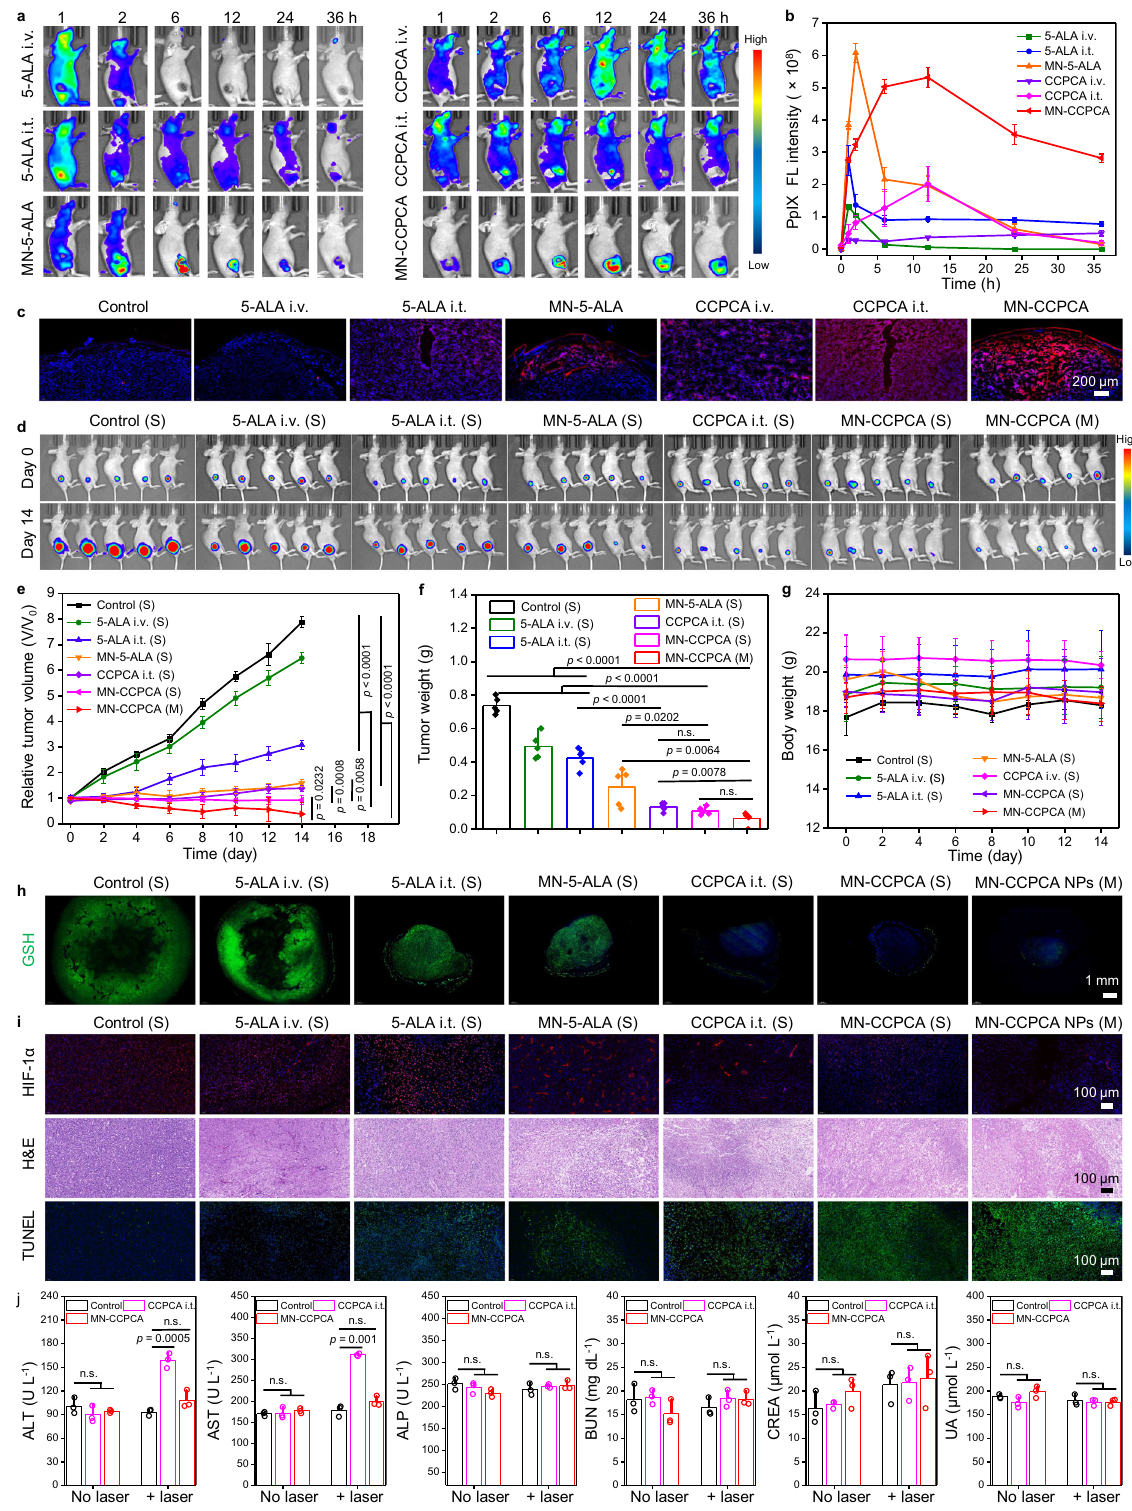
Fig. 13c). Compared to the lower apoptosis FL signal of fl uorescein- dUTP in other groups, the higher fully covered FL signal of fl uorescein-dUTP in the MN-CCPCA (M) group revealed the most intense signal of apoptosis in tumors (Fig. 8i and Supplementary Fig. 13d). Severely pyknotic nuclei and negligible Ki67 expression were observed in MN-CCPCA (M) groups (Fig. 8i and Supplementary Fig. 13e,